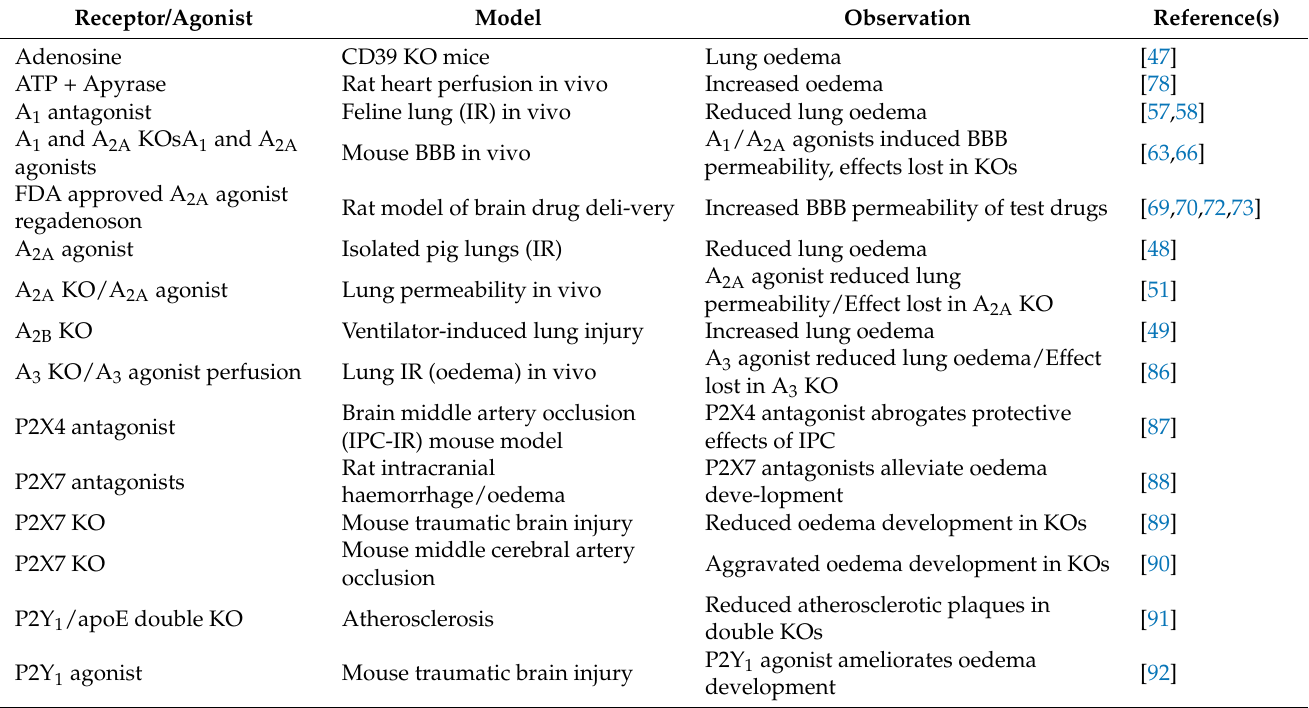
Table 1. Effect of purinergic receptor activation/inhibition on endothelial barrier of various vascular beds. Receptor/Agonist